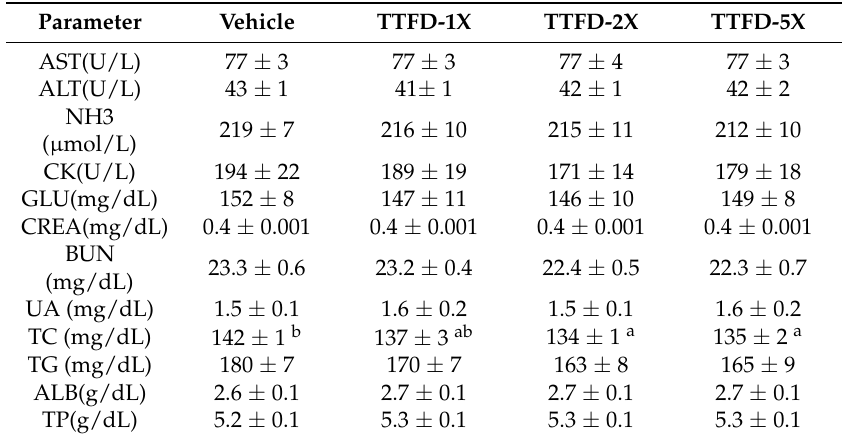
Table 4. The effects of TTFD on clinical biochemical analysis at the end of the experiment.